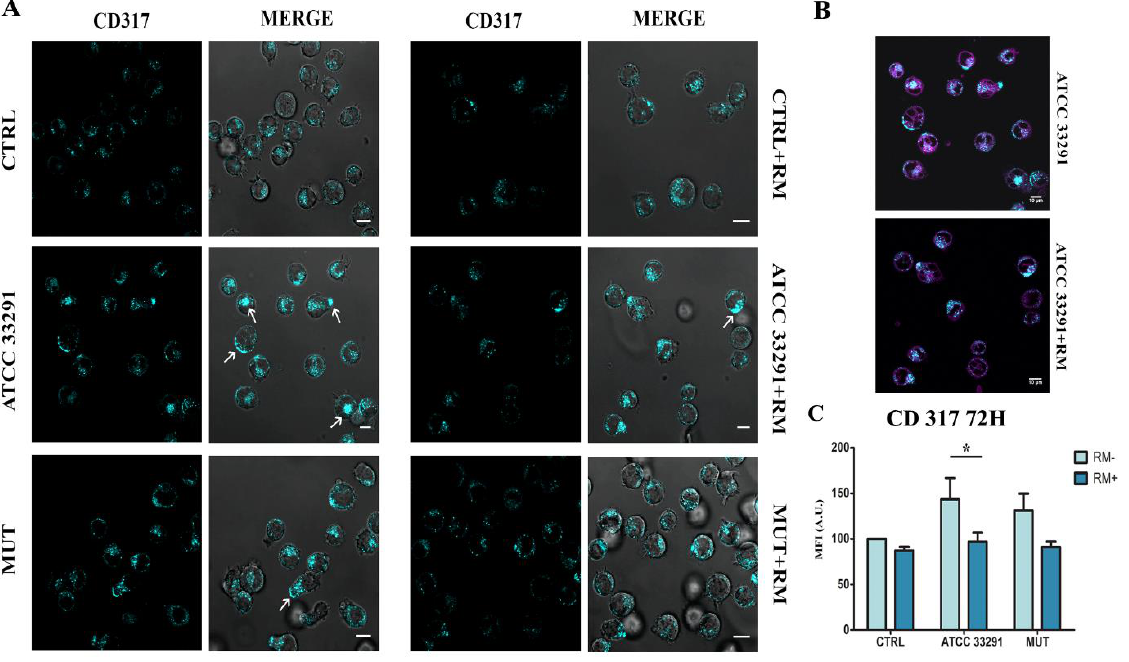
Figure 6. Expression of CD317/tetherin: localization and quantitation by confocal and cytometric analyses, respectively. ( A ) Single confocal optical sections of CD317 of untreated U937 cells (CTRL) and U937 cells after 72 h of treatment by lysates, with and without RM. Bars: 10 µM. ( B ) A comparison between RM- and RM+ ATCC33291 lysate (CDT active)-treated cells: magenta stain represents ER-tracker fluorescence, added to better visualize CD317 distribution and to resemble the ER decrease induced by RM. Bars: 10 µM ( C ) Statistical histograms of CD317 MFI were calculated after 72 h from lysate administration in cells with and without RM. Each value was converted to arbitrary units (A.U.),